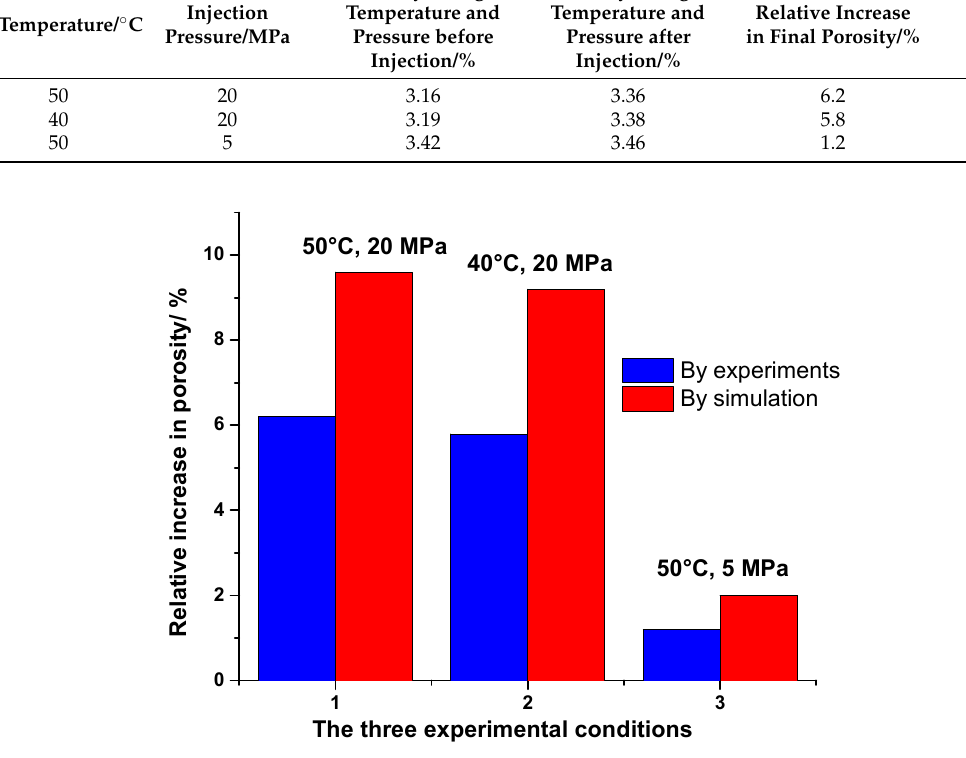
Figure 16. Comparison of the relative increase in final porosity obtained from experiments and simulations under different temperature and pressure conditions.